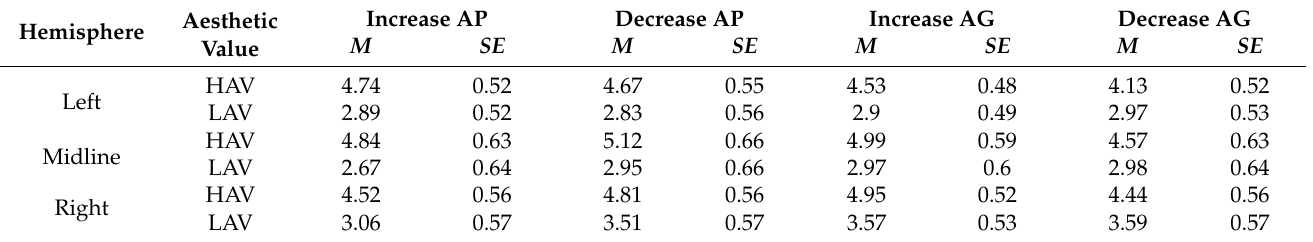
Figure 5. The descriptive statistics bar graph of the average amplitude of P2 about the hemisphere and emotion regulation. Table 5. P2 amplitudes (mean and standard error).